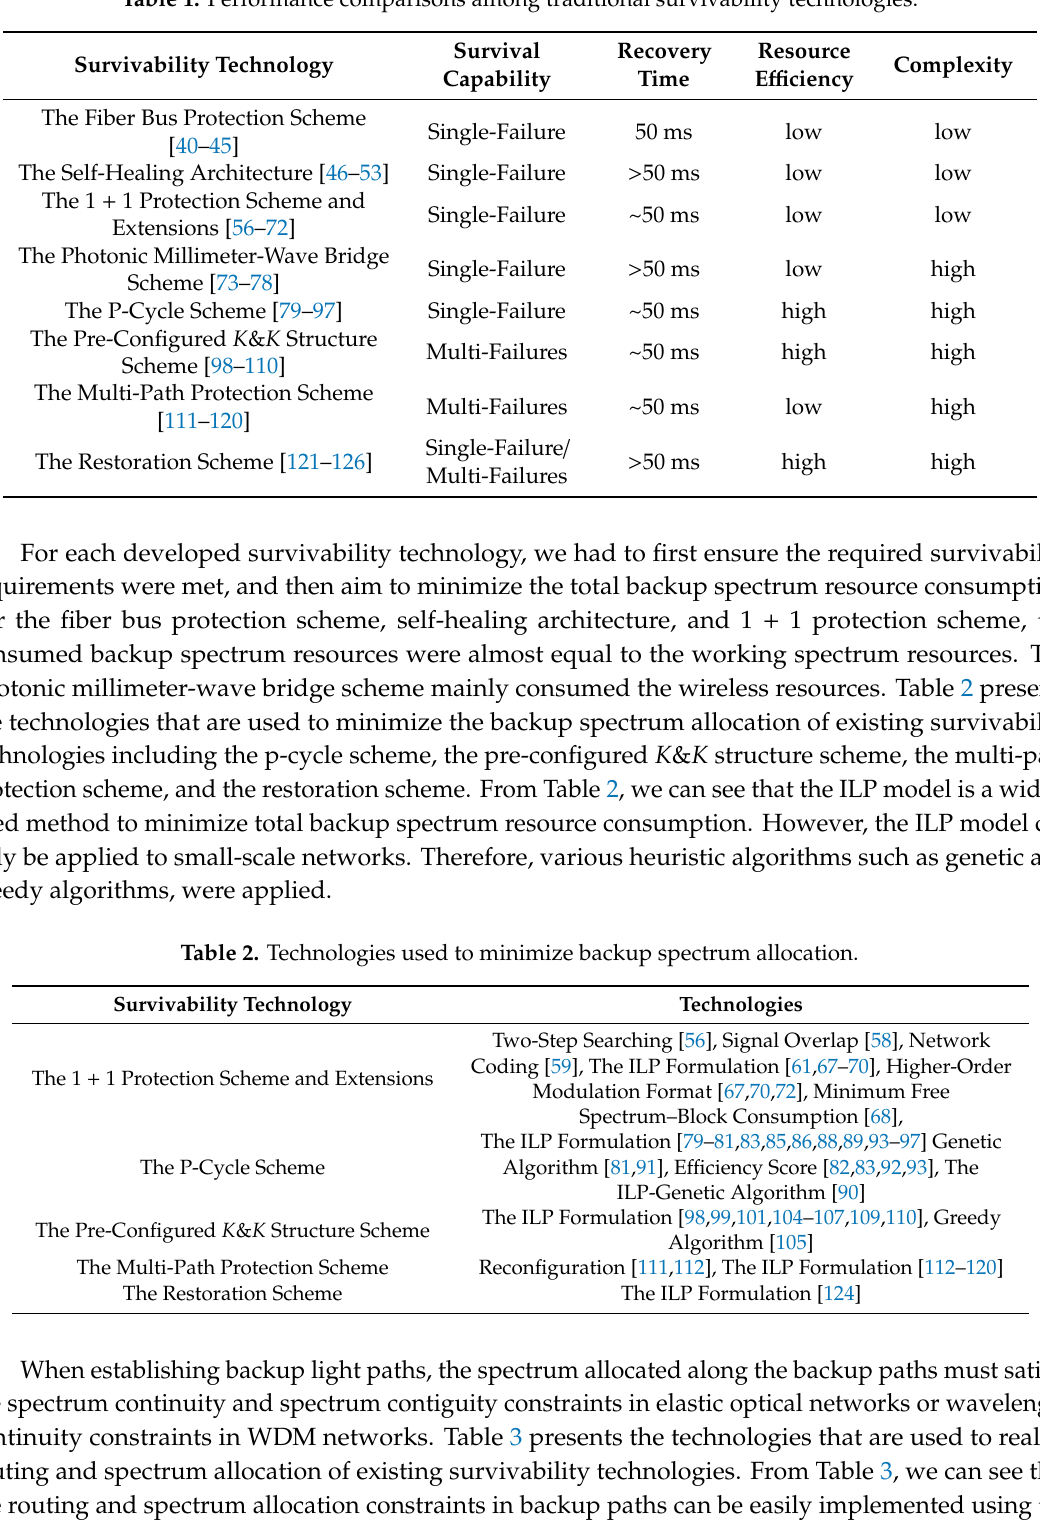
Table 1. Performance comparisons among traditional survivability technologies.